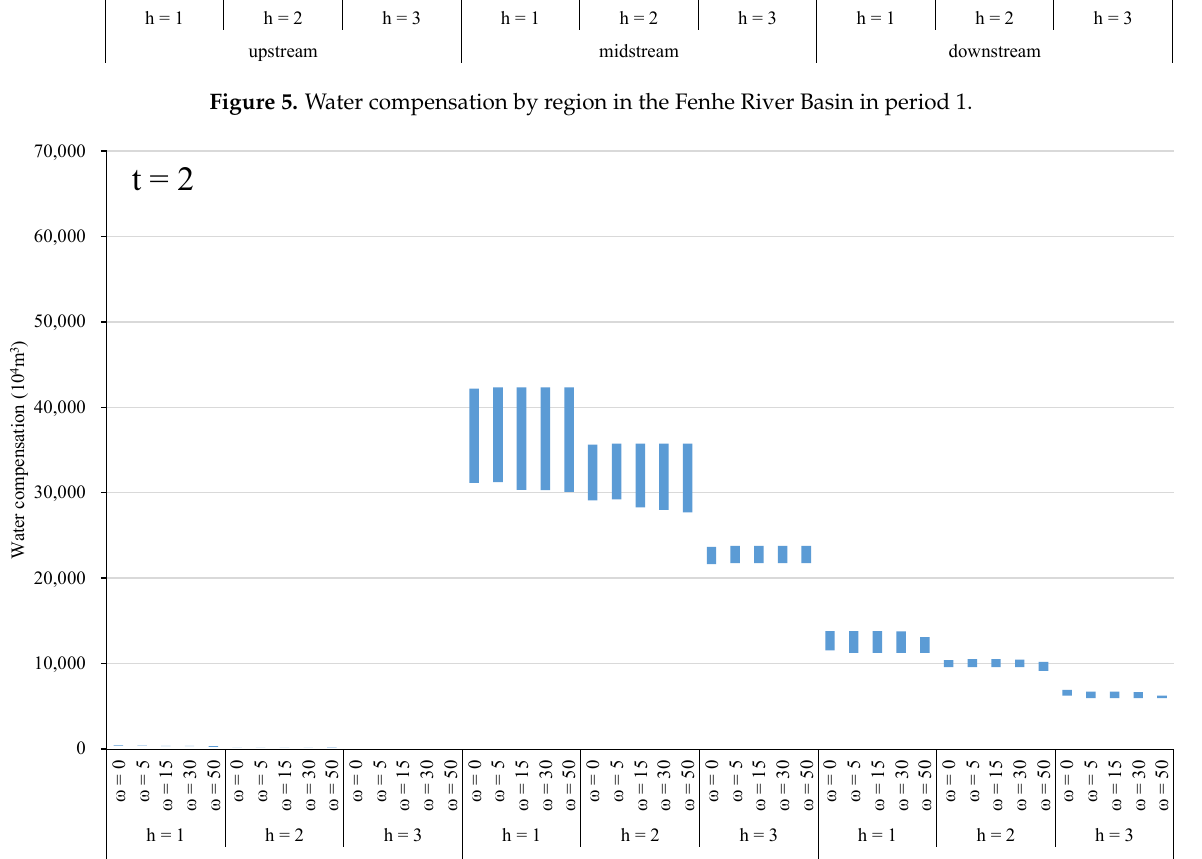
Figure 7. Water compensation by region in the Fenhe River Basin in period 3.